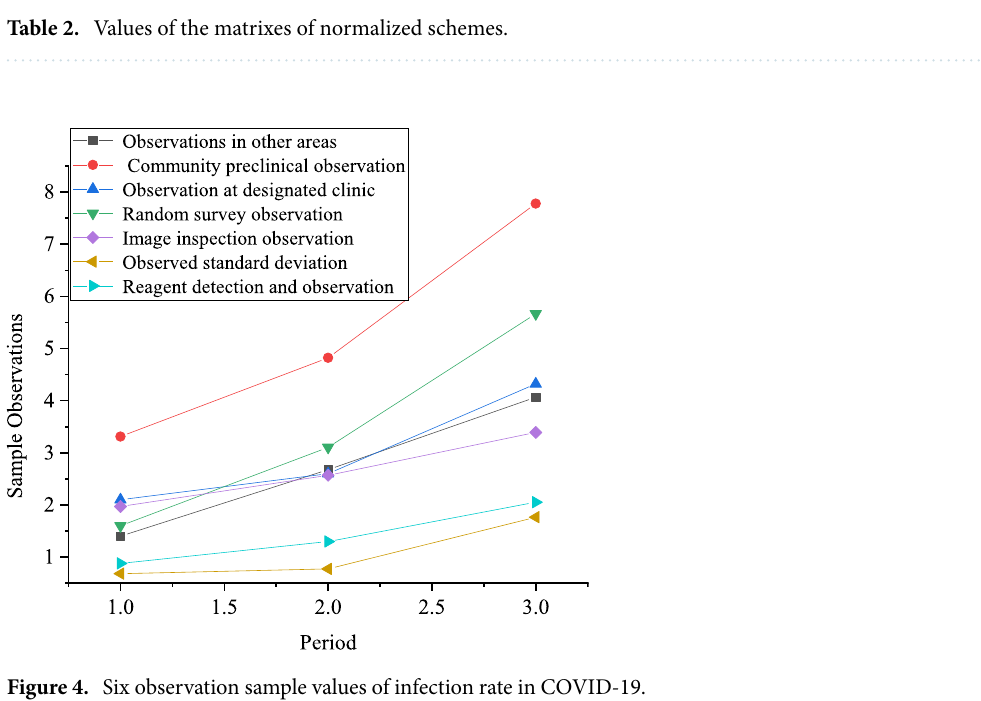
Figure 4. Six observation sample values of infection rate in